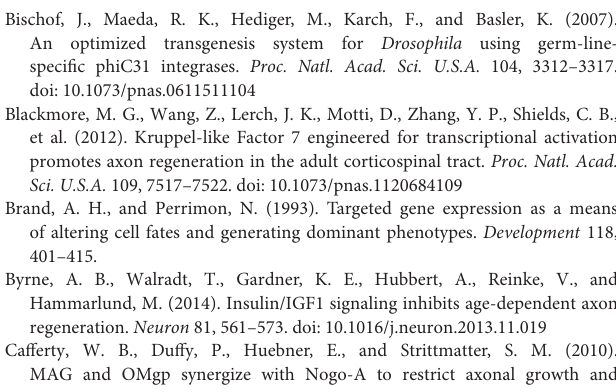
Supplementary Table 1 | Candidate genes tested in the genetic screen for axonal outgrowth in development. Supplementary Table 2 | Number of samples across the various